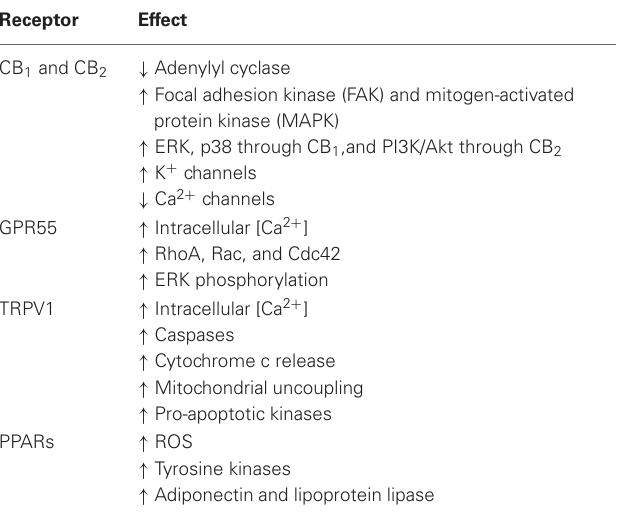
Table 1 | Signal transduction pathways triggered by eCBs at different target receptors.